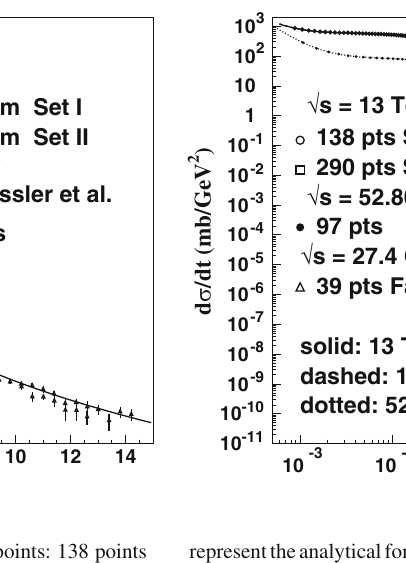
Fig. 5 a Analytical representation for all 467 data points: 138 points representtheanalyticalformfor13TeVexcludingthe3-gluonexchange of Set I [1] and 290 of Set II [2] from Totem measurements at 13 TeV, tail term. b Joint plot of data at 52.806 GeV [32,33] and Totem 13 TeV √ s = 27 . 4 GeV from FNAL measurements [8]. The plus 39 points at data, with the analytic solutions obtained with the KFK model [6]. The points have energy scales differing by more than 200, and still the data global representation of 467 (138+290+39) points is constructed with in the large | t | region have similar magnitudes. The universality is con- the unique solution given in Table 1 plus the R ggg ( t ) term as in Eq. (14), sistently present at ISR energies with results χ 2 = 1 . 731 (total statistical and systematic errors) and χ 2 = 5 . 042 (statistical errors), as shown in Table 2. The dashed lines